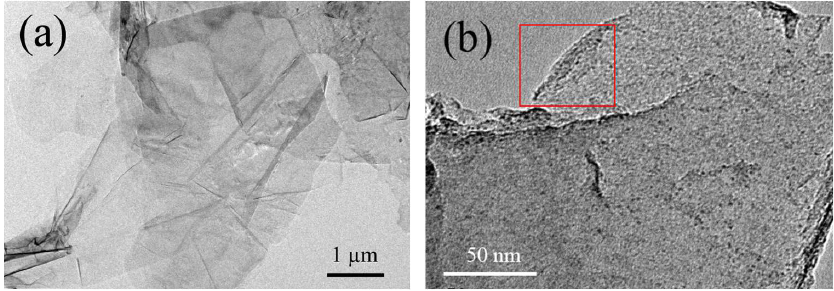
Figure 1. Typical TEM images of EG. The scale bar is ( a ) 1 μm and ( b ) 50 nm. In the red rectangular zone, the curved edge indicates the graphene sheet is few-layered. zone, the curved edge indicates the graphene sheet is